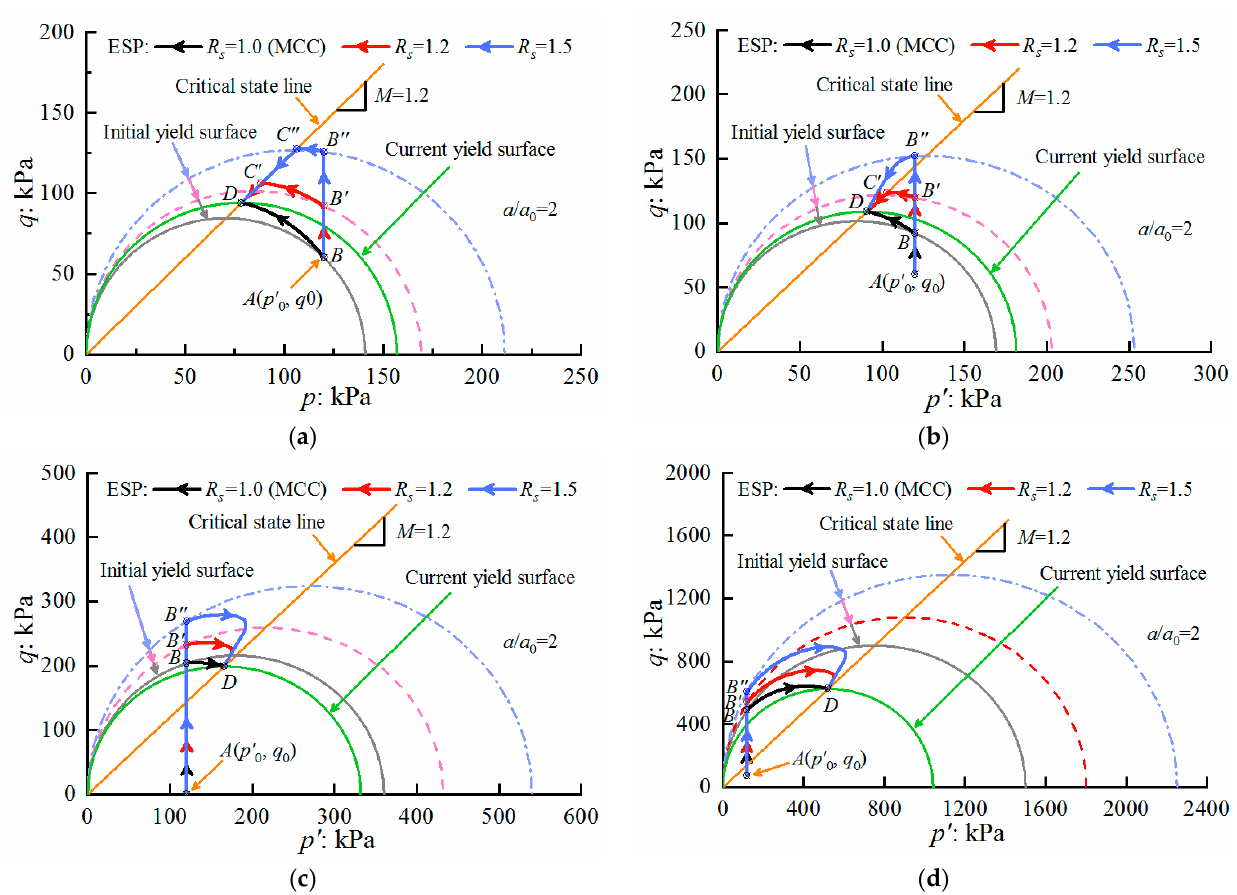
Figure 13. Effective stress paths for the structured and the corresponding reconstituted soils: ( a ) R = 1; ( b ) R = 1.2; ( c ) R = 3; ( d ) R = 10.